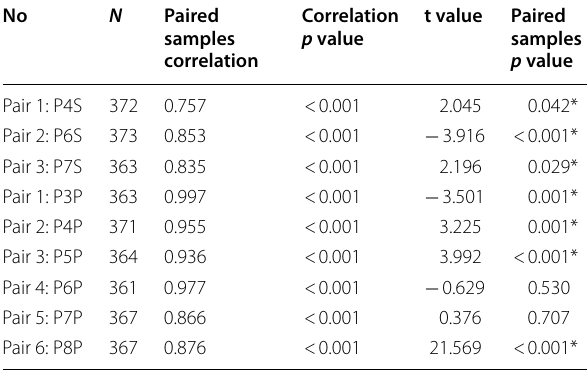
Table 7 Paired sample statistics for symmetry analysis of pelvic and sacral